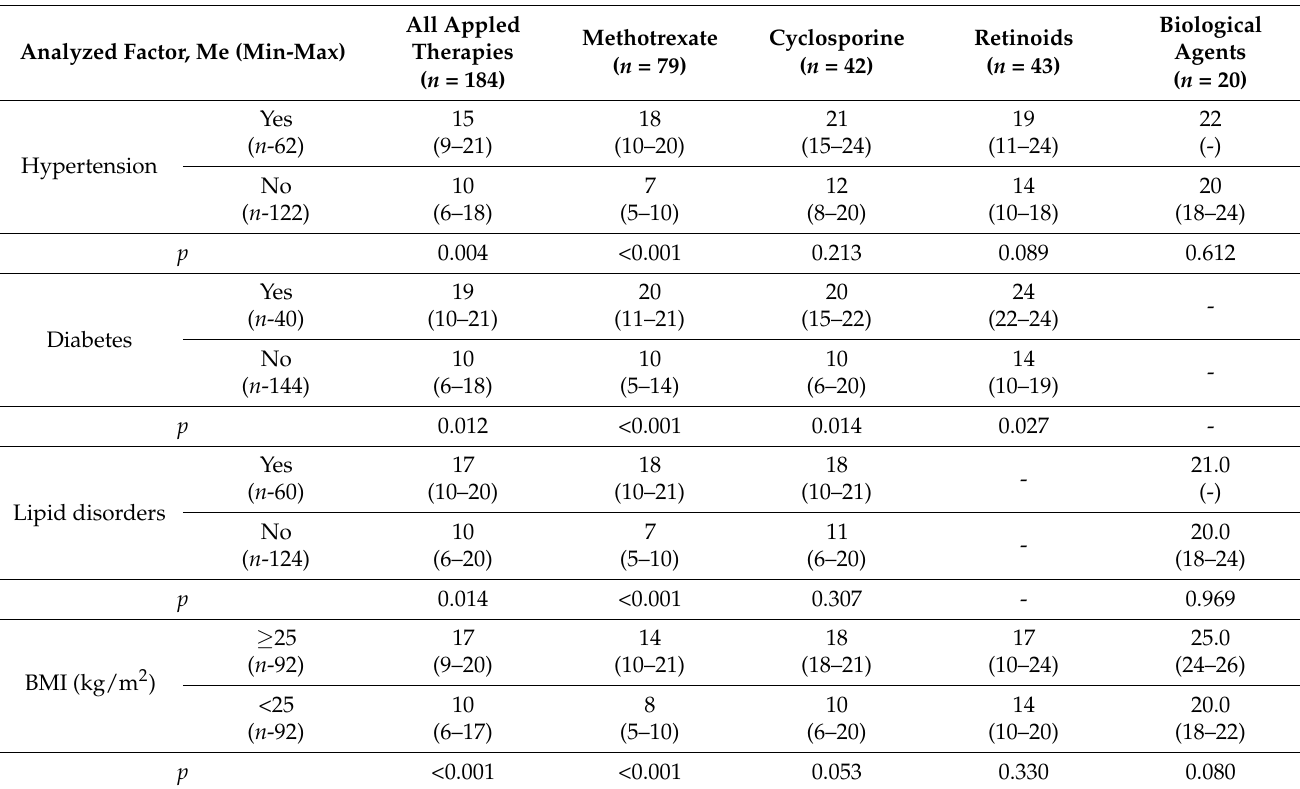
Table 2. The DLQI score before the treatment (a baseline visit), after a 3-month therapy (a control visit) as well as DLQI reduction in psoriasis patients treated with different therapies depending on the presence of comorbidities, BMI score and smoking